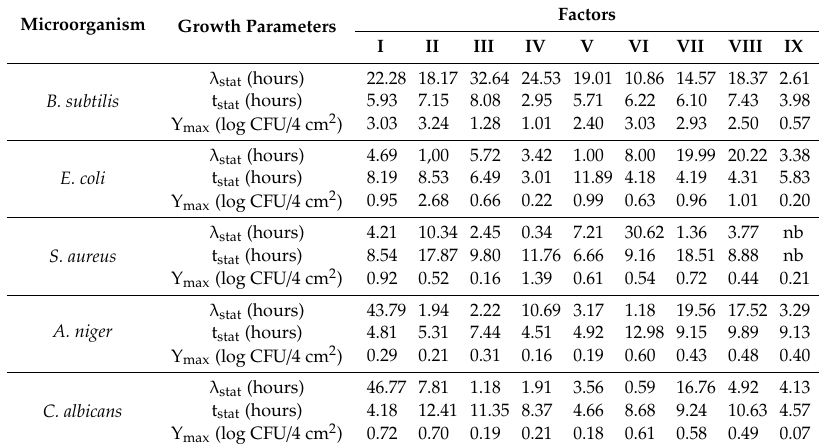
Table 4. The influence of factors on the growth parameters of microorganisms on the filtering nonwoven.